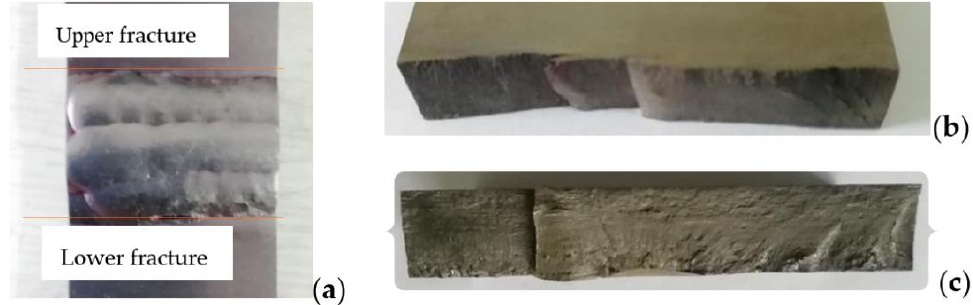
Figure 13. ( a ) Upper and lower fracture positions; ( b ) Upper fracture surface; ( c ) Lower fracture surface.